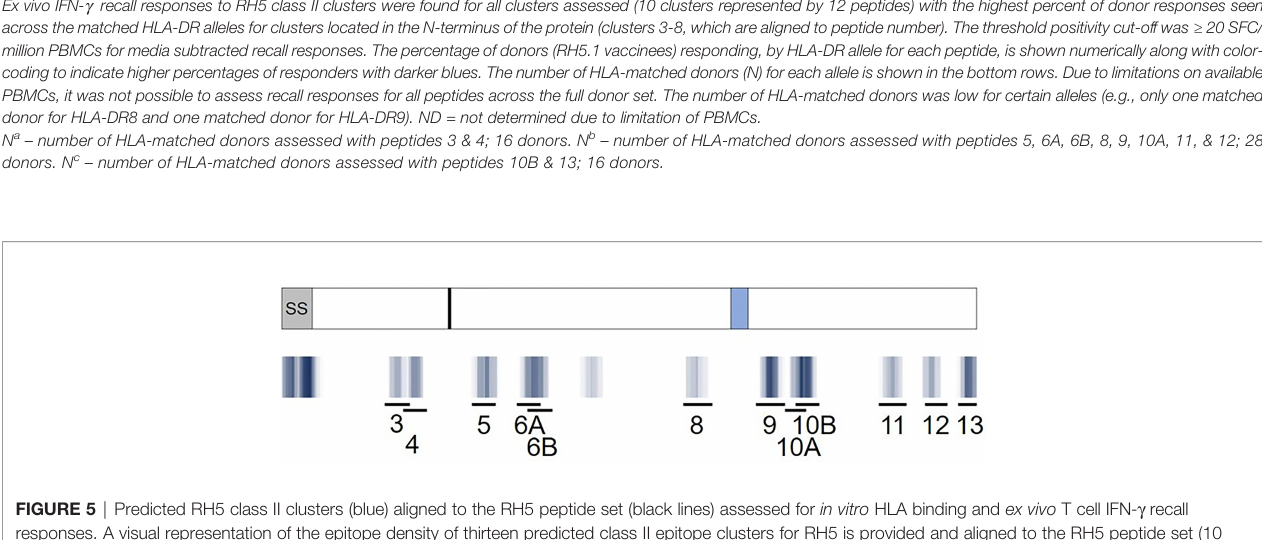
Ex vivo IFN- g recall responses to RH5 class II clusters were found for all clusters assessed (10 clusters represented by 12 peptides) with the highest percent of donor responses seen across thematched HLA-DR alleles forclusters located in the N-terminus of the protein(clusters 3-8, which are aligned to peptide number). Thethreshold positivity cut-offwas ≥